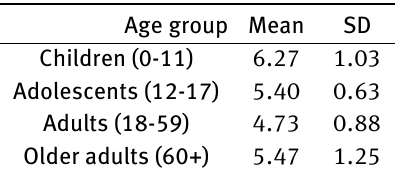
Table 1: Harmful/Helpful ratings for each age group, on a 1 (very harmful) to 7 (very beneficial)